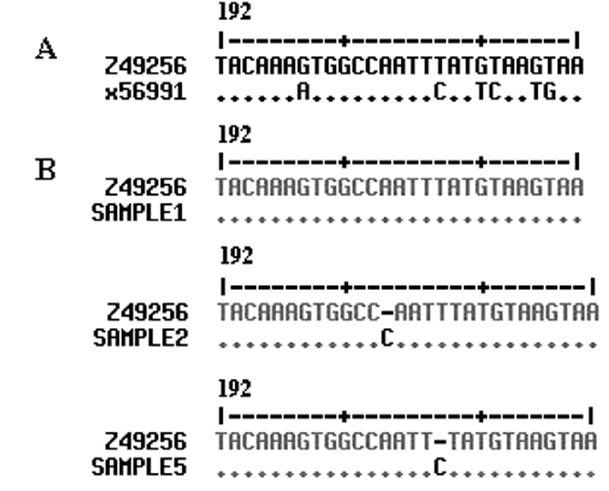
Fig. 2 – A: Sequence differences between E. dispar (Z 49256) and E. histolytica ( × 56991) ribosomal RNA genes. B: Sequence differences between E. dispar (Z 49256) and E. dispar ribosomal RNA genes identified in the stool samples. * Nucleotide sequences identified in samples 4, 7, 8, 9 and 10 are identical to those of sample